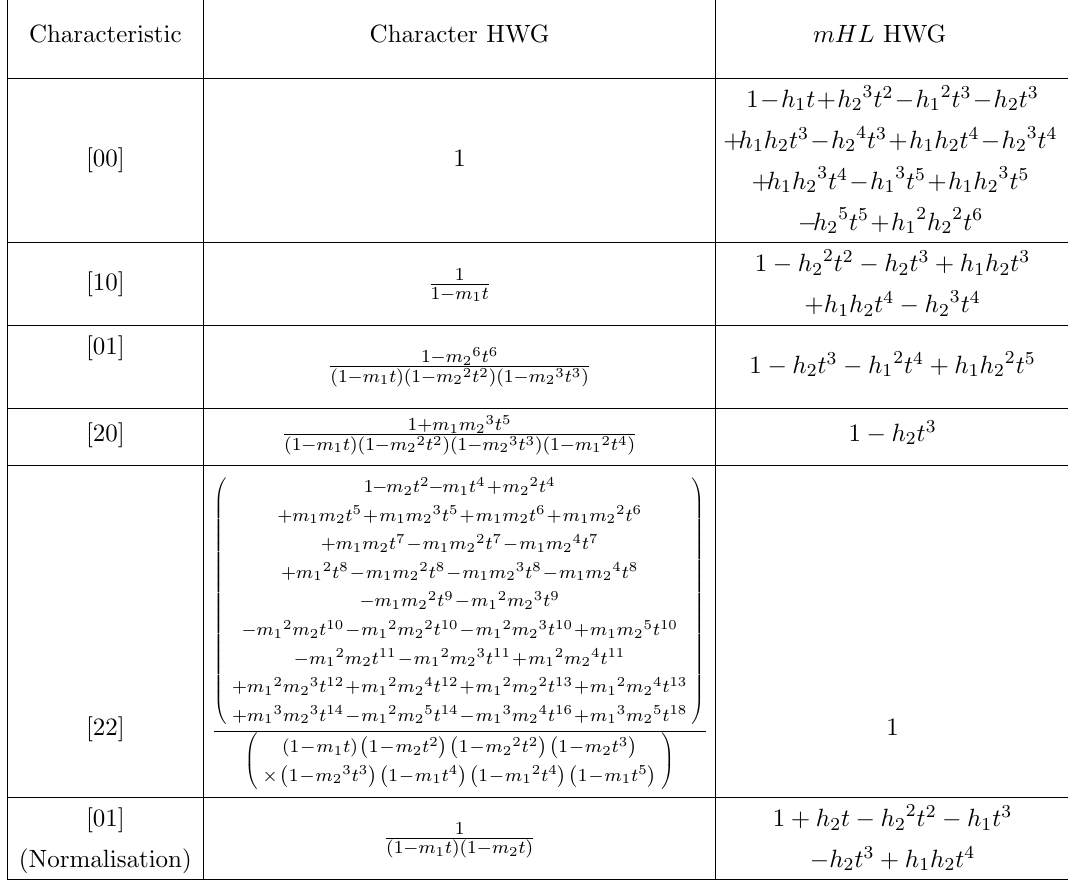
Table 4 . G 2 orbits and HWGs. Both the non-normal 8 dimensional nilpotent orbit and its normalisation are